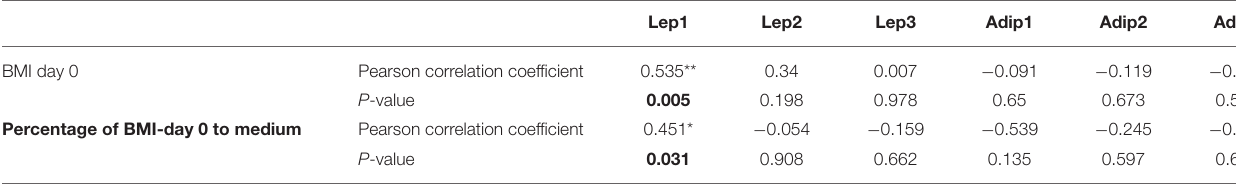
TABLE 7 | Pearson correlation analysis of body mass index and adipocytokine